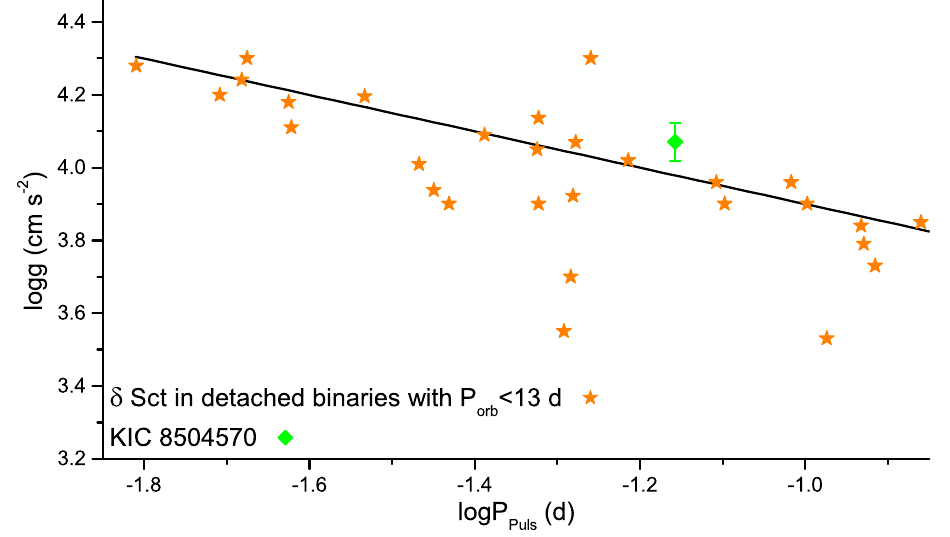
Figure 11. Location of the δ Scuti (primary) star of KIC 8504570 within the log g − P pul diagram. Symbols and lines have the same meanings as in Figure